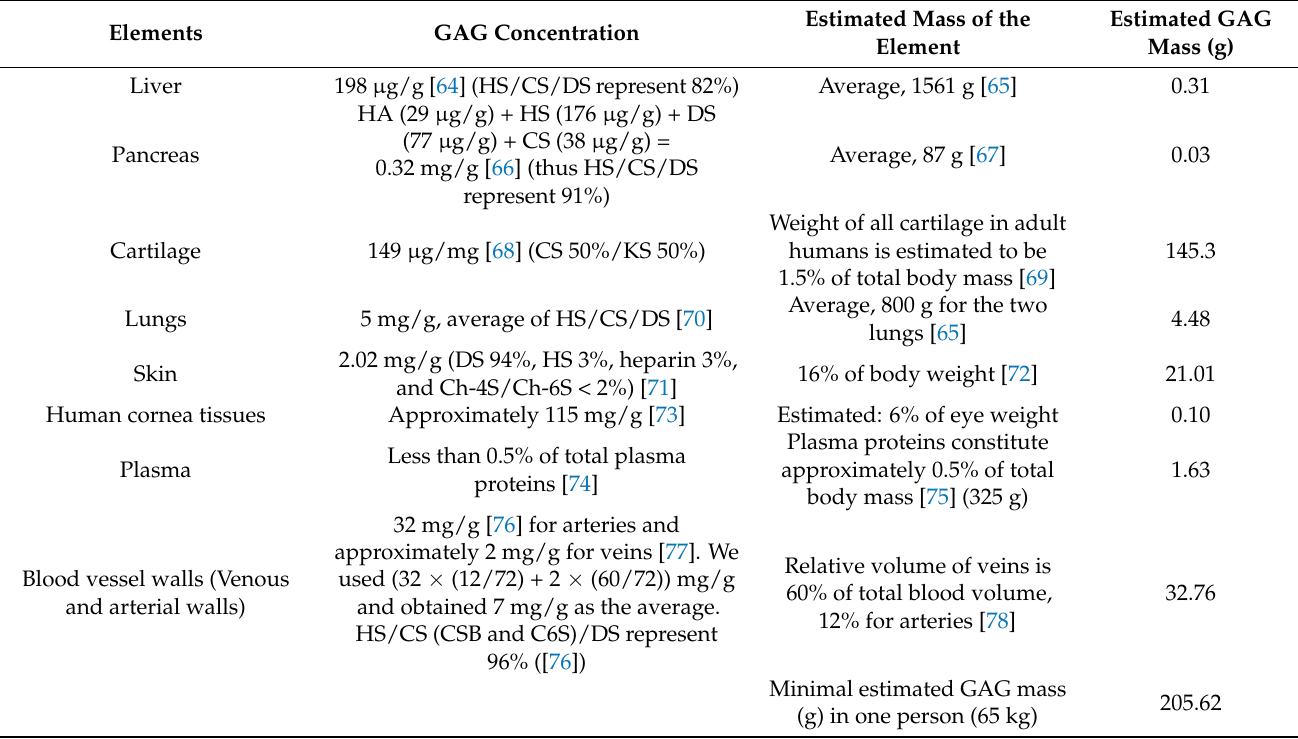
Table 3. Minimal GAG mass estimation (in g) in a healthy person weighing 65